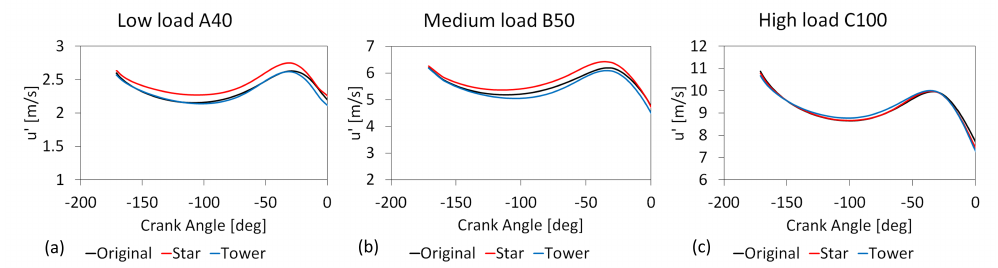
Figure 8. Turbulence intensity evolution inside the combustion chamber for the three different piston bowl geometries under low-load ( a ), medium-load ( b ), and high-load ( c ) conditions.